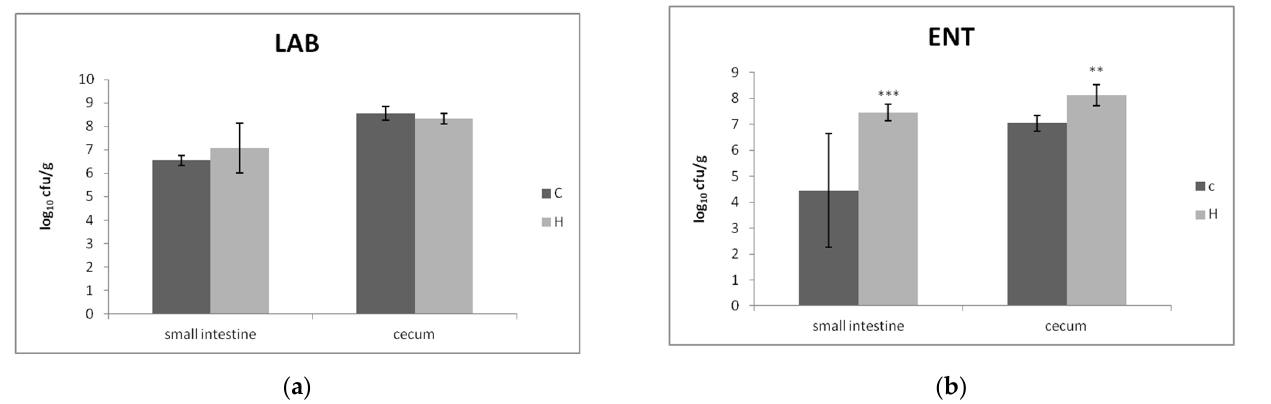
Figure 4. The influence of 0.5% HS on the counts of ( a ) lactic acid bacteria (LAB) and ( b ) enterobacteria (ENT) in the contents of the small intestine and the caecum. C: control group; H: layers fed a diet enriched with supplementation of 0.5% HS. Columns marked with stars are significantly different from control: ** p < 0.01; *** p < 0.001.